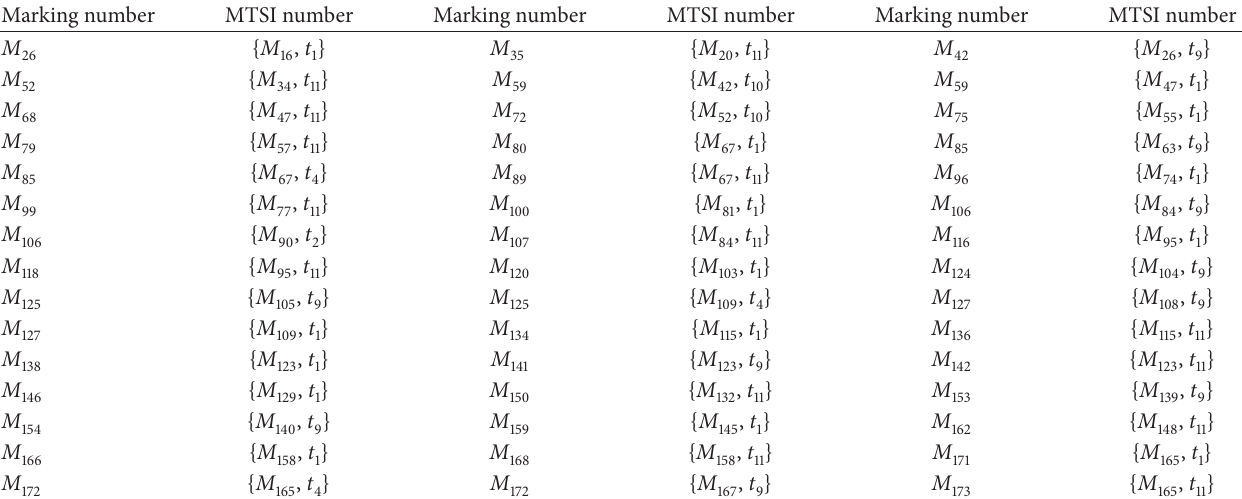
Table 4: The information of all MTSIs.